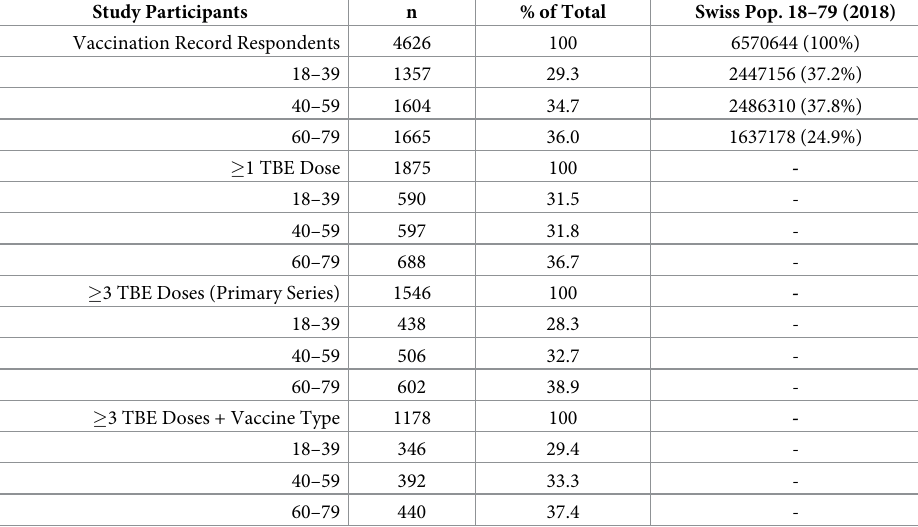
Table 1. Study participants by age group and number of TBE vaccine